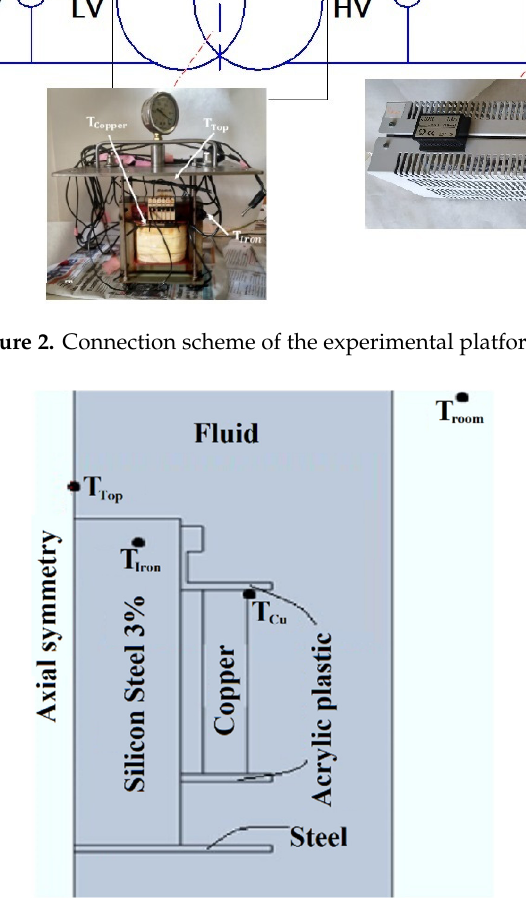
Figure 2. Connection scheme of the experimental platform.